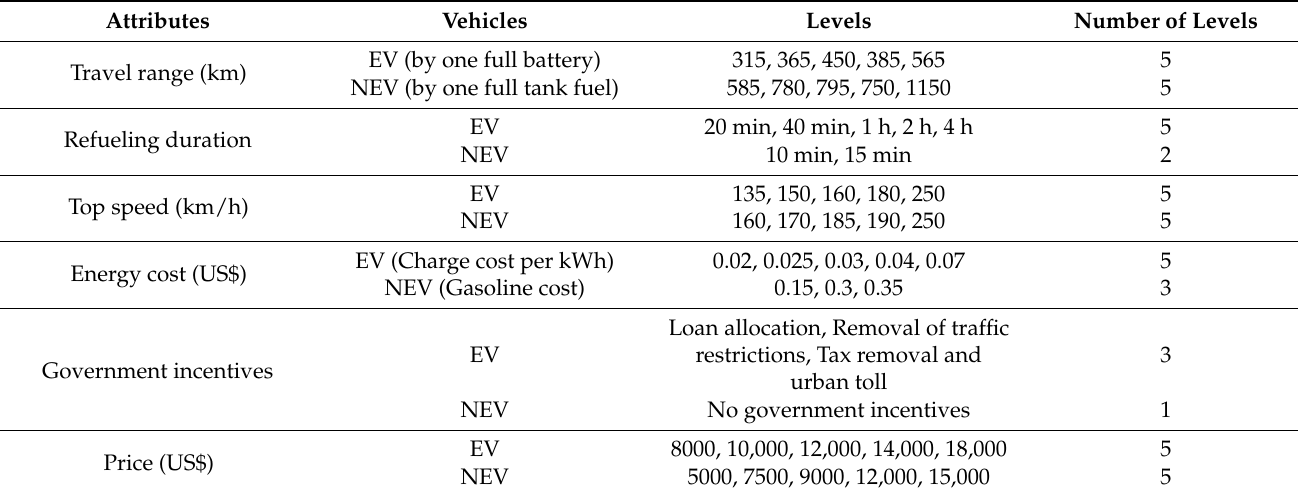
Table 3. Vehicle attributes and corresponding